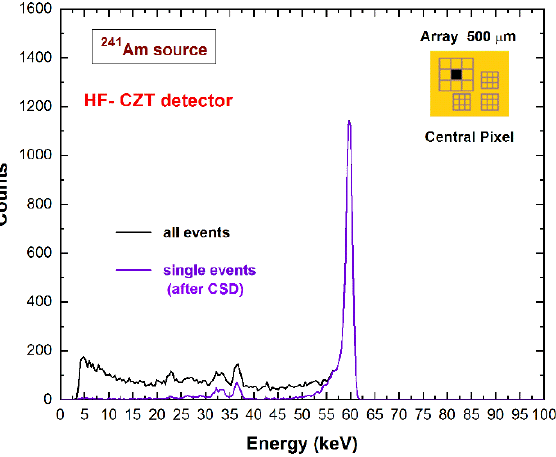
Figure 3. Comparison between the raw 241 Am energy spectrum (black line) and the spectrum (violet line) after charge-sharing discrimination (CSD). The energy spectra are related to the central pixel of the 500 μ m array of the HF-CZT detector. After CSD, 56% of all events are rejected.